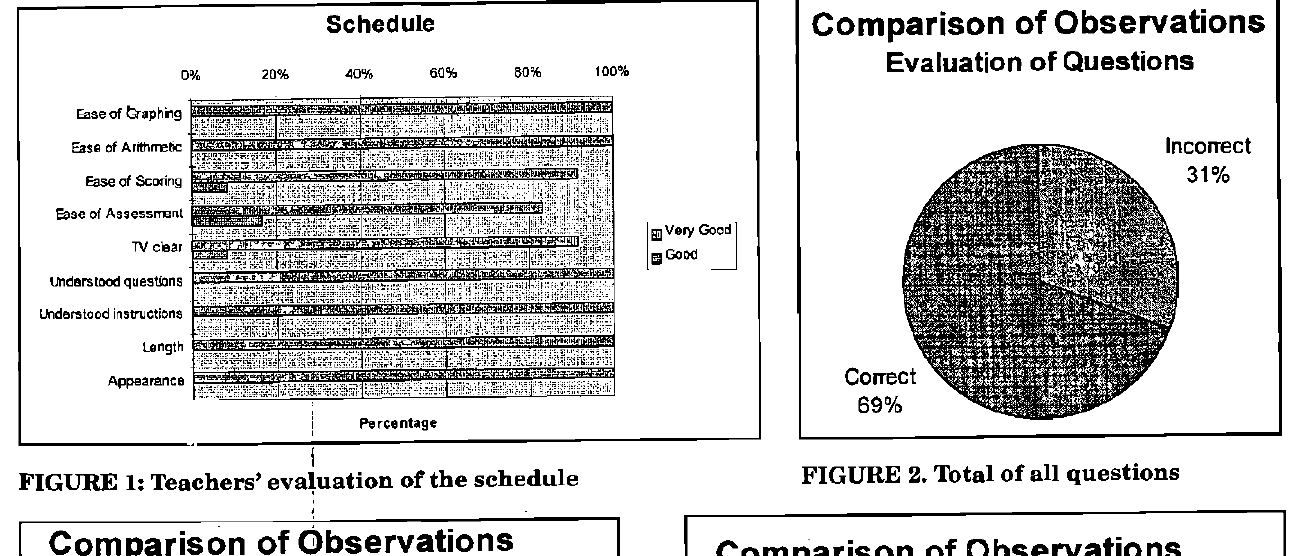
FIGURE 1: Teachers' evaluation of the schedule FIGURE 2. Total of all questions